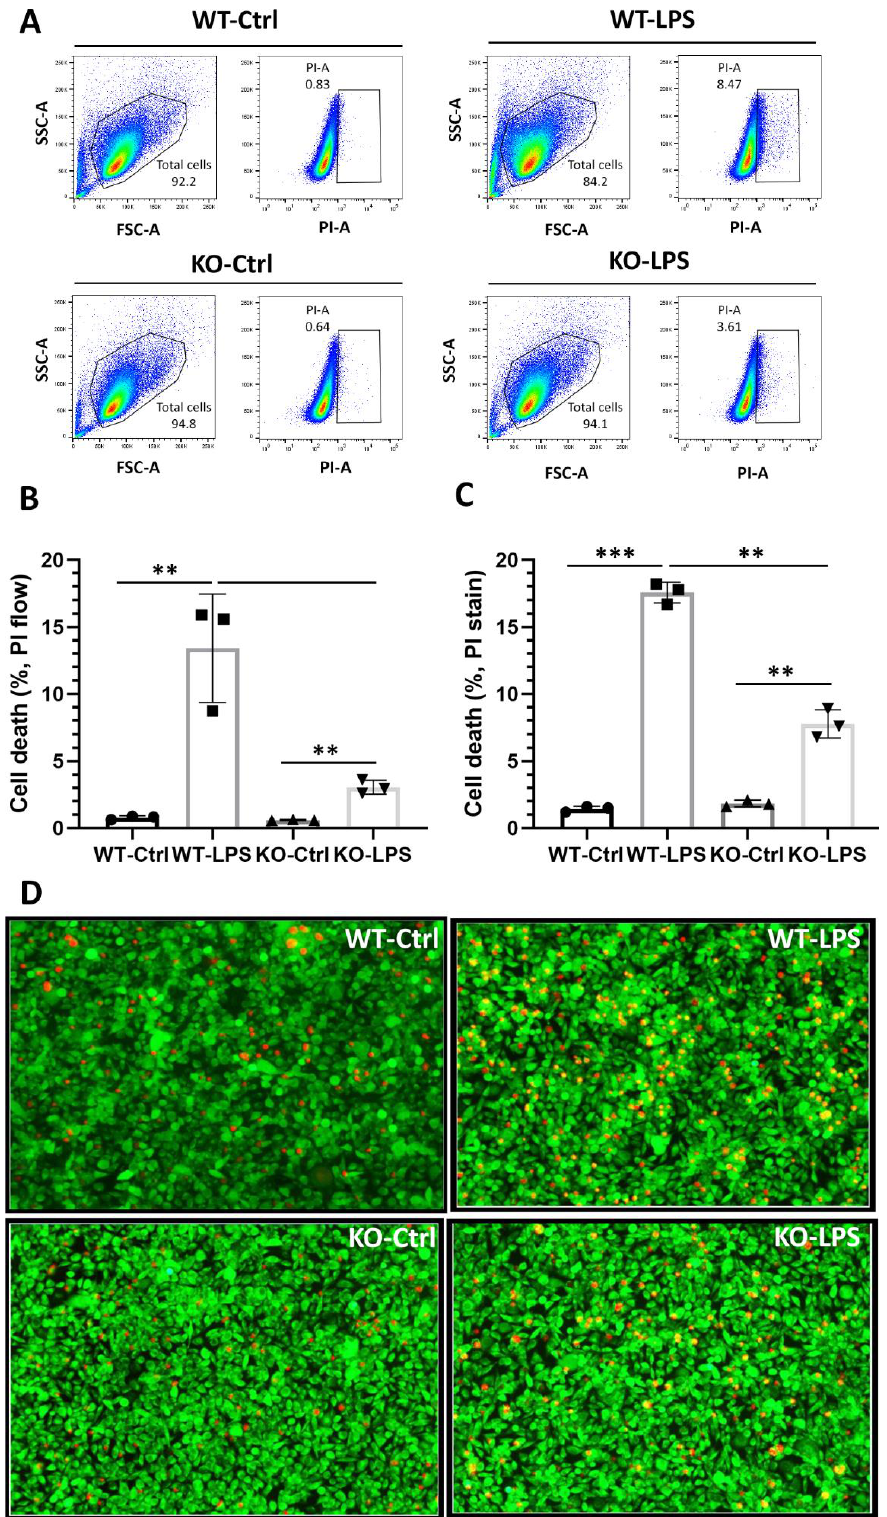
Figure 6. IRF1 deletion reduces microglial cytotoxicity to photoreceptors. ( A ) PI-gated flow cytometry analysis for the cone-like 661 W cells treated with PBS control (WT-Ctrl), the conditioned media